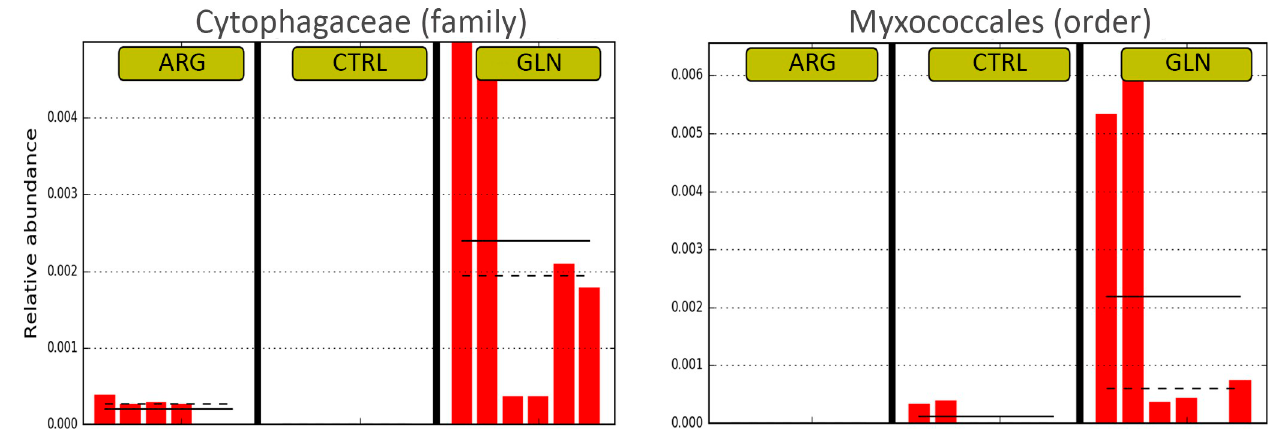
Fig 6. Representation of differences in gut bacterial composition between treatments. Differential features plots for Cytophagaceae (family) on left, and Myxococcales (order) on right showing higher abundance in GLN treatment. Dashed line corresponds to median and full line corresponds to average between samples from the same treatment.